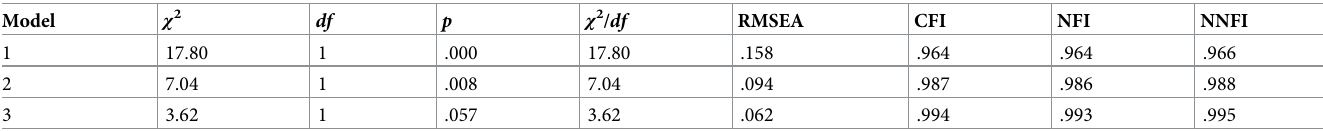
Table 3. Model fit indices of alternative path